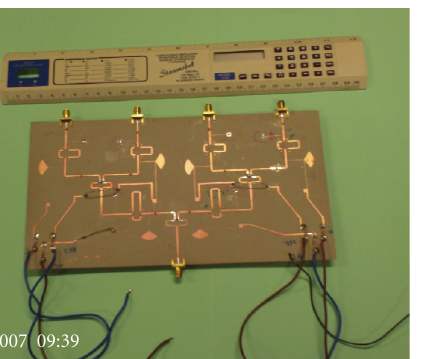
Figure 9: Phase antenna prototype. View of the radiating element and vertical subarray inputs.